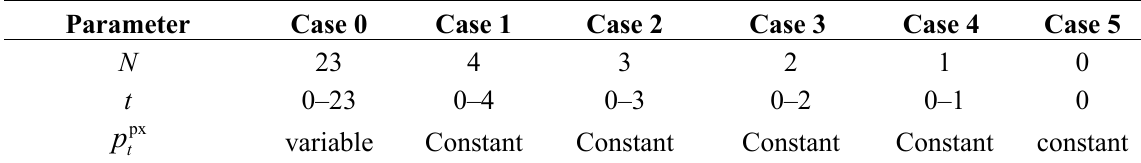
Parameter Case 0 Case 1 Case 2 Case 3 Case 4 Case